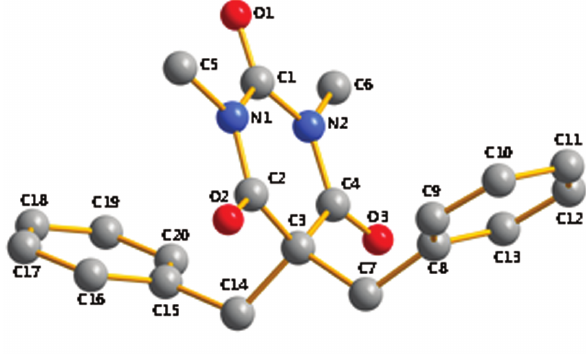
Table 2: Fractional atomic coordinates and isotropic or equivalent isotropic displacement parameters (Å 2